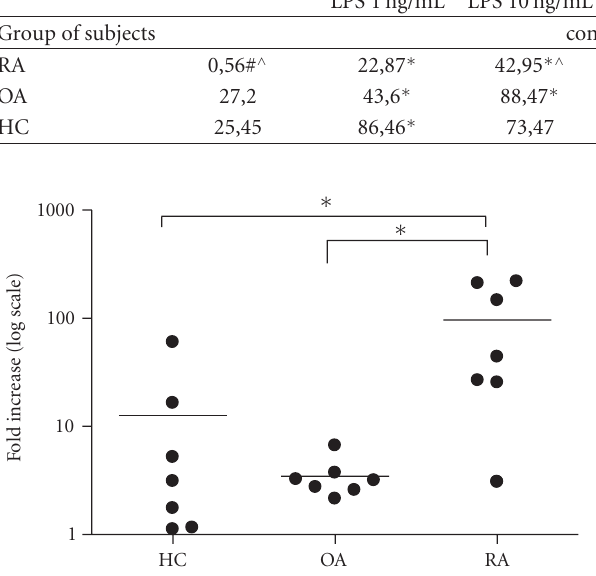
Figure 1: Individual changes in IL-6 concentration in the super- natants of human leucocytes culture after stimulation with LPS at 100 ng/mL; log10 scale; HC-healthy controls, OA-osteoarthrosis, RA-rheumatoid arthritis; ∗ P < . 03, Wilcoxon’s